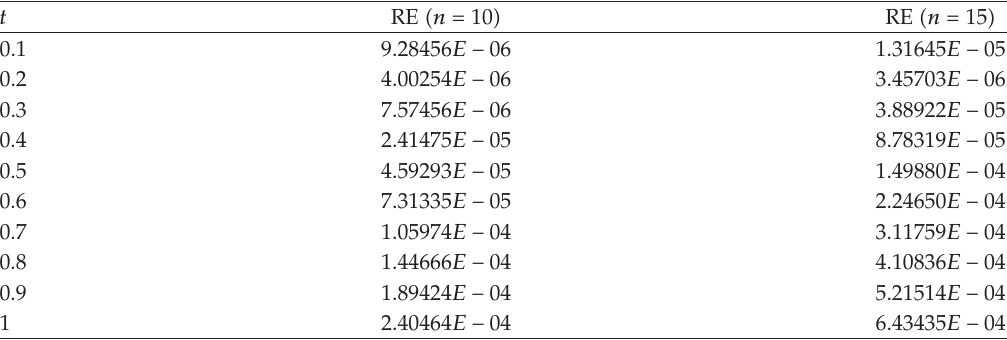
(cid:3) t (cid:4) , for Example 3.2. 50